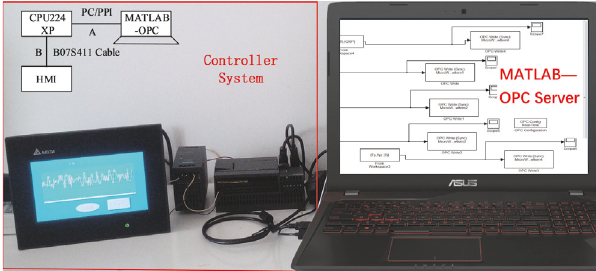
Figure 9: The experimental